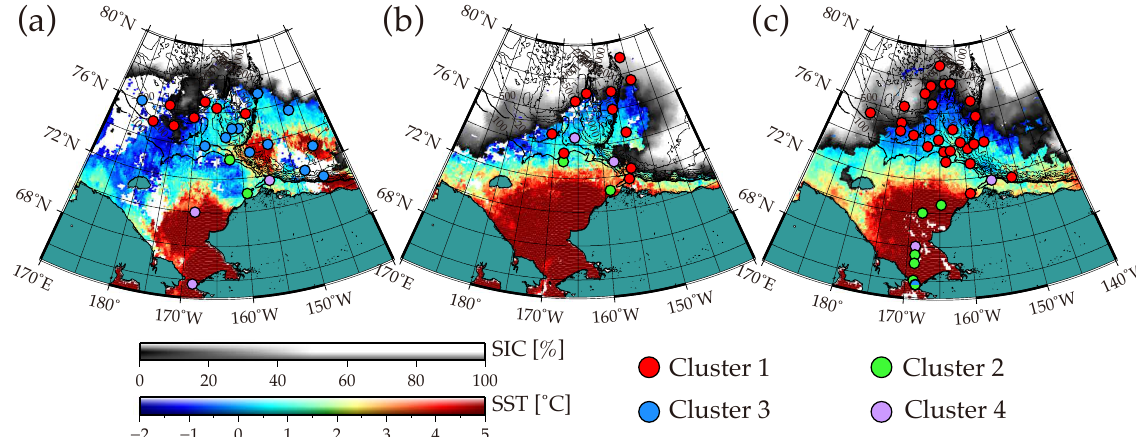
Fig. 4. Distribution of dominant phytoplankton groups at the surface layer in (a) 2008, (b) 2009 and (c) 2010. Clusters were identified by cluster analysis. SIC data were collected by AMSR-E on September 1; SST data were collected by MODIS and composited to 9-days average centred on 1 September of each year. Depth contours indicate 100-, 200-, 500-, 1000-, 1500-, and 2000-m intervals, respectively.